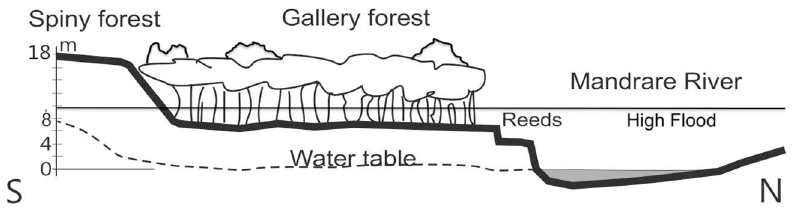
Figure 2. Generalised north-south cross section of Malaza forest showing the river at average annual low-flow, bank-side growth of reeds ( Phragmites mauritianus ) on a lower terrace frequently eroded by floods, height of intermittent high floods (in 1971 up to 1.5 m above forest floor) and an upper, ancient terrace rising up to 10 m above the gallery forest floodplain.